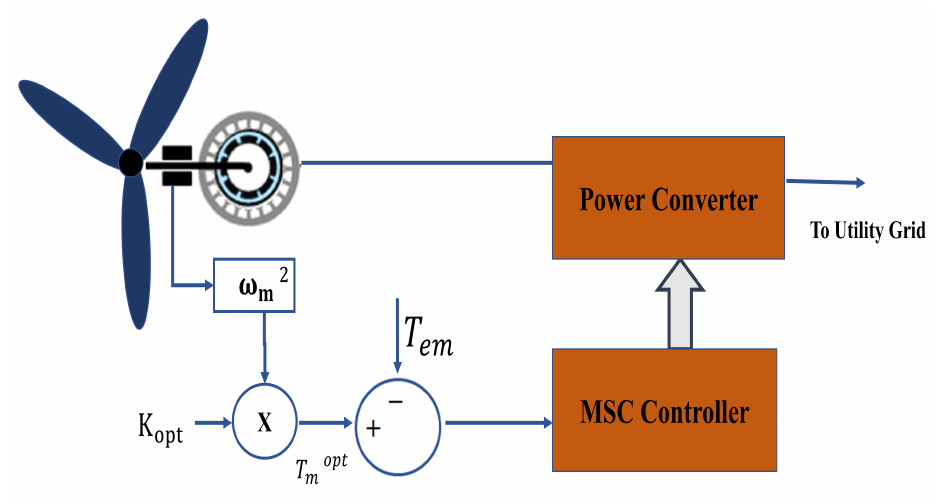
Figure 8. OT MPPT